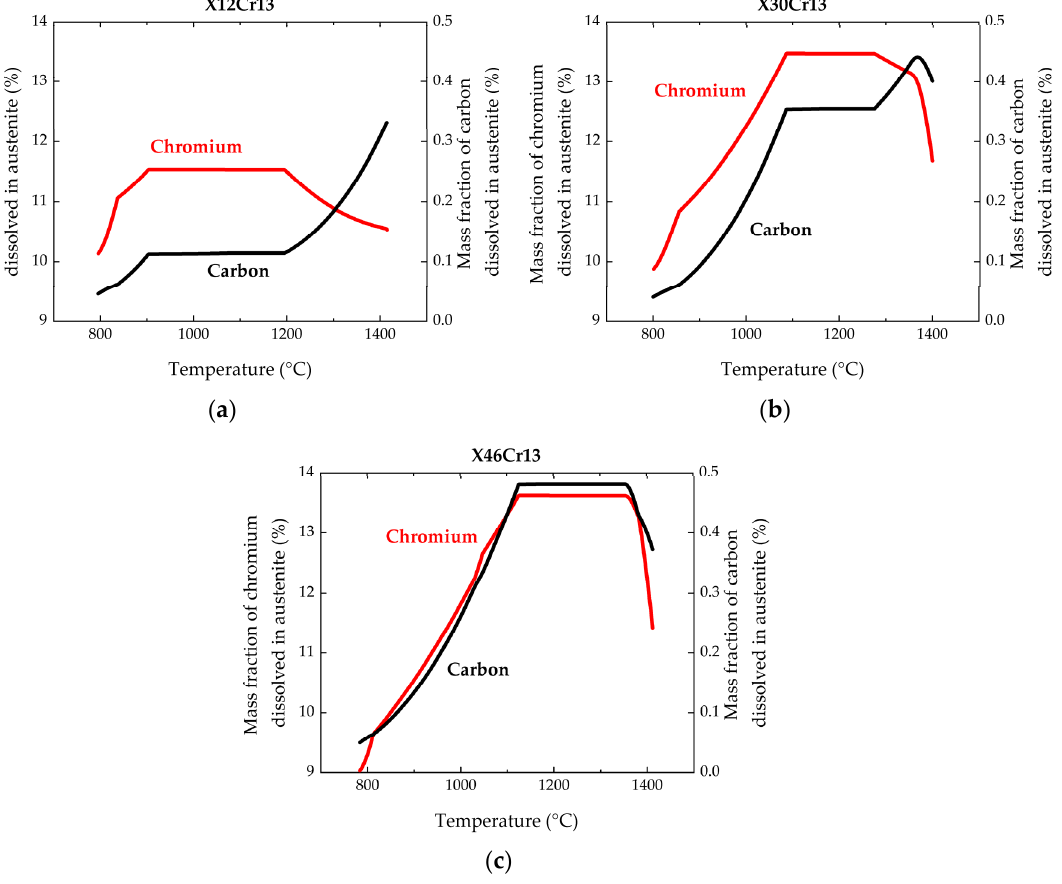
Figure 6. Mass fraction of the contents of C and Cr alloying elements in solid solution at the austenitic temperatures, i.e., between 800 and 1400 °C for the X12Cr13 ( a ), X13Cr13 ( b ), and X46Cr13 ( c ) alloys.